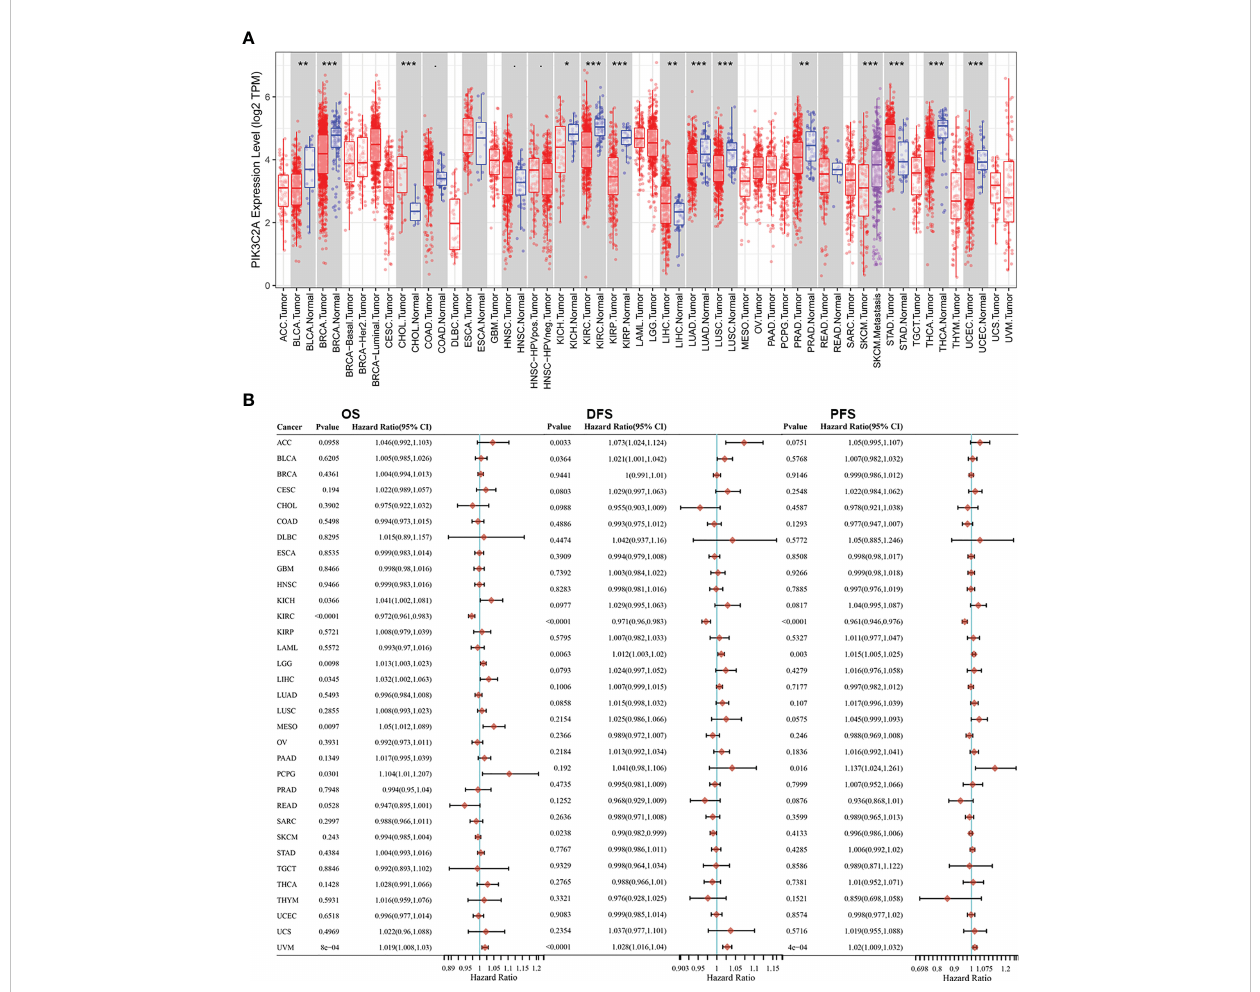
FIGURE 1 PIK3C2A expression levels and prognostic roles in different types of human cancers. (A) Increased or decreased expression of PIK3C2A in different cancer tissues, compared with normal tissues in TIMER. * p < 0.05, ** p < 0.01, *** p < 0.001. (B) Hazard ratio and p-value of PIK3C2A involved in univariate COX regression analysis and the OS, DFS, and PFS of various